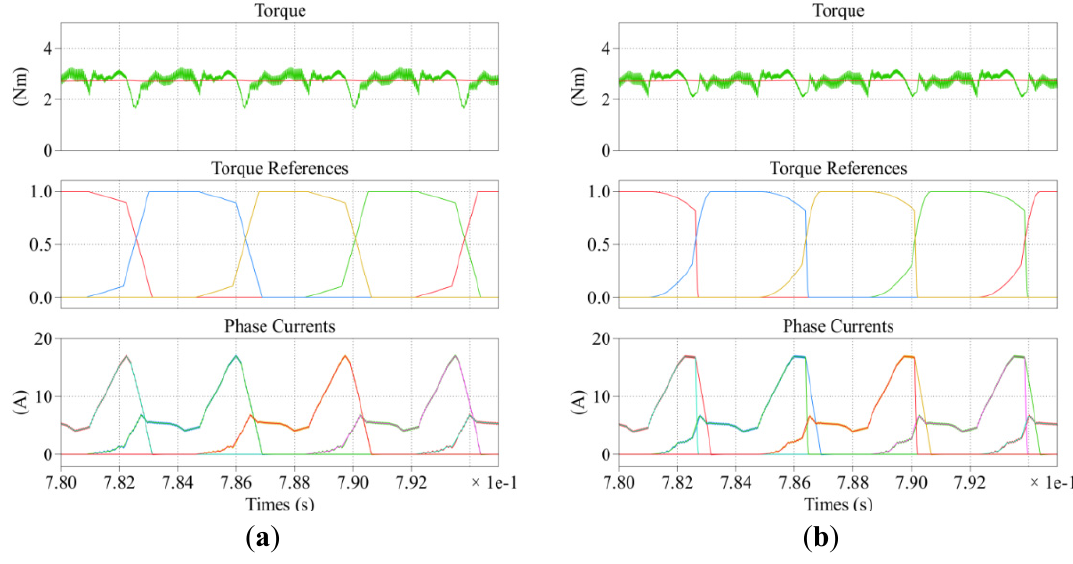
Figure 11. Simulation results at 600 rpm: ( a ) asymmetric TSF; ( b ) non-unity